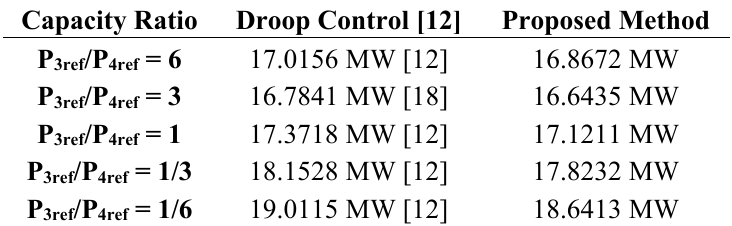
Table 4. Copper loss of VSC-HVDC (with local load).